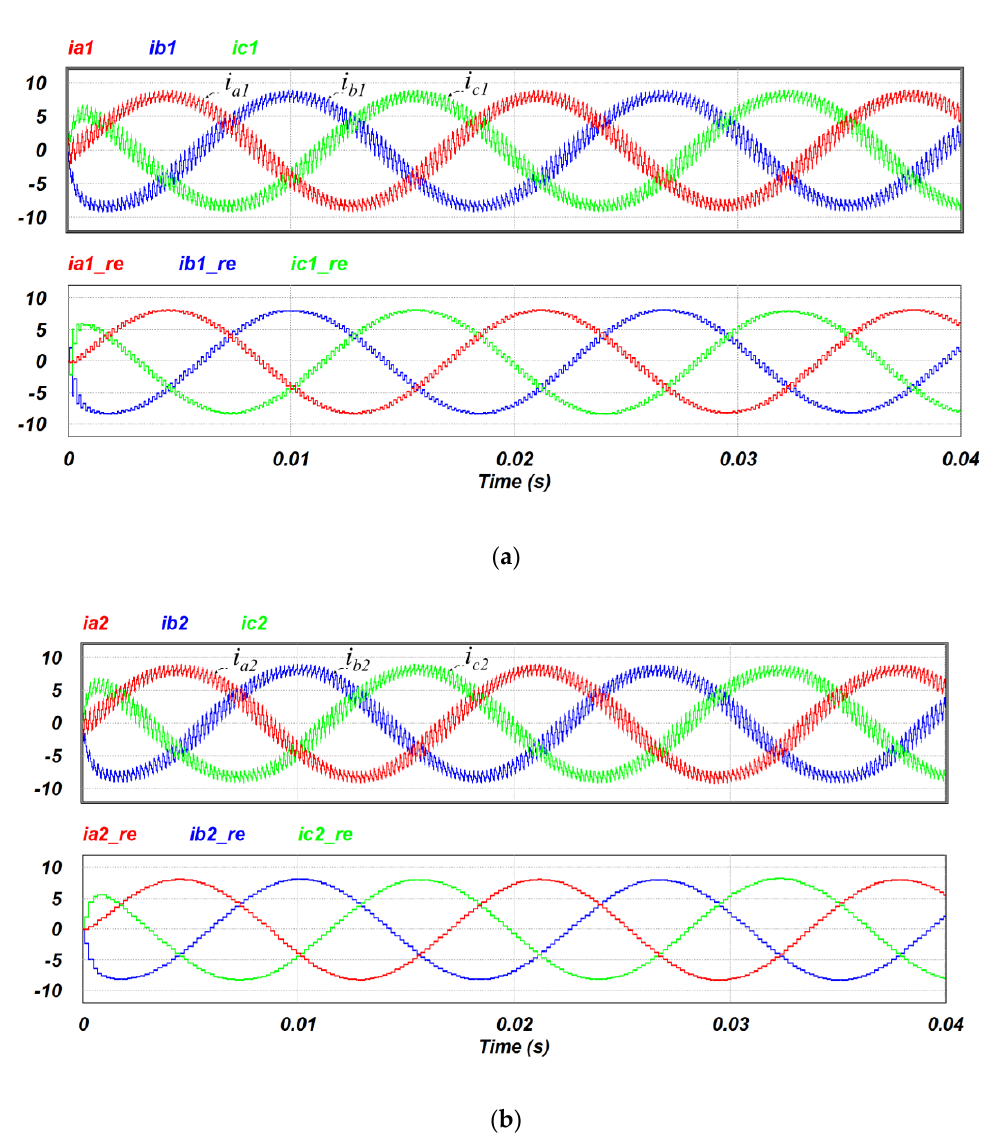
Figure 4. Simulation result that shows the current sensor output with the actual currents.